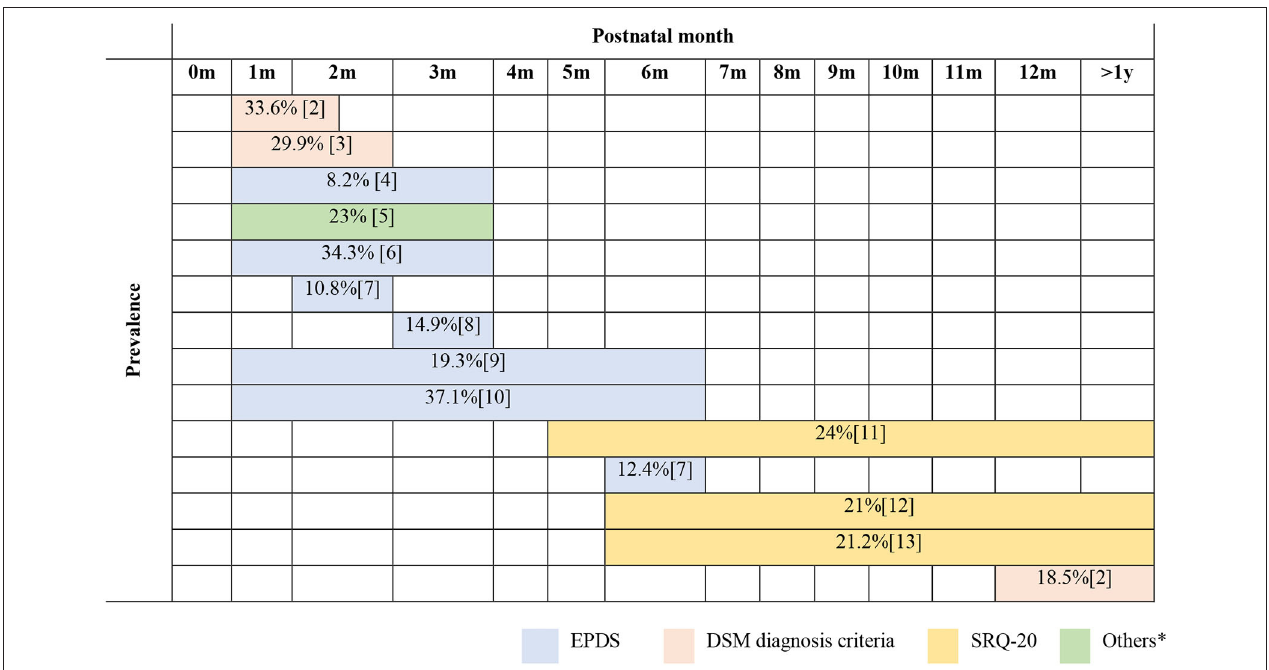
FIGURE 2 | Prevalence of postpartum common mental disorders against postnatal screening time points reported by published articles in Vietnam from 2010 to